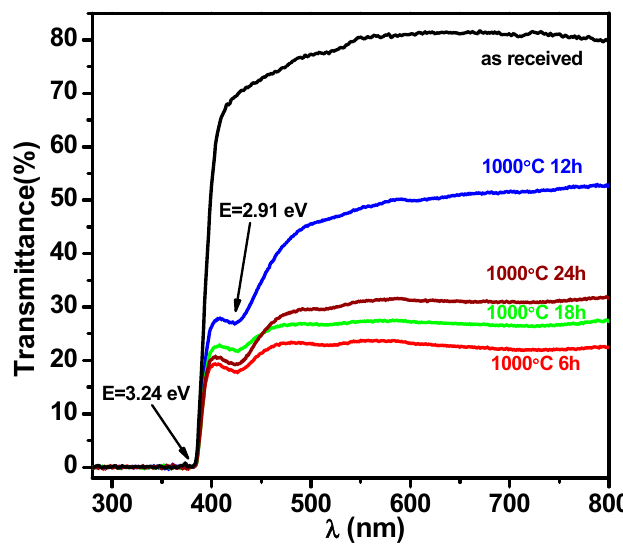
Figure 1. The transmittance of SrTiO 3 single crystals after 6, 12, 18, 24 h annealing compared to the “as received” one.